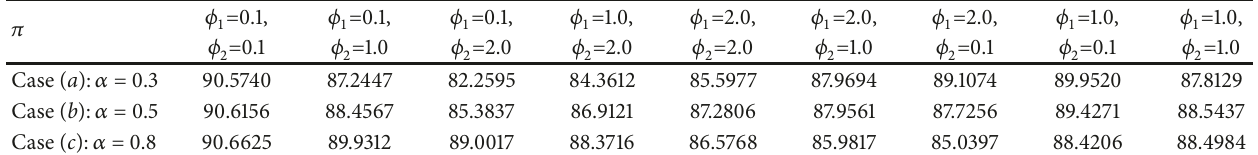
Table 5: The impact of fairness concern on the total expected profit 𝜋 under three cases.